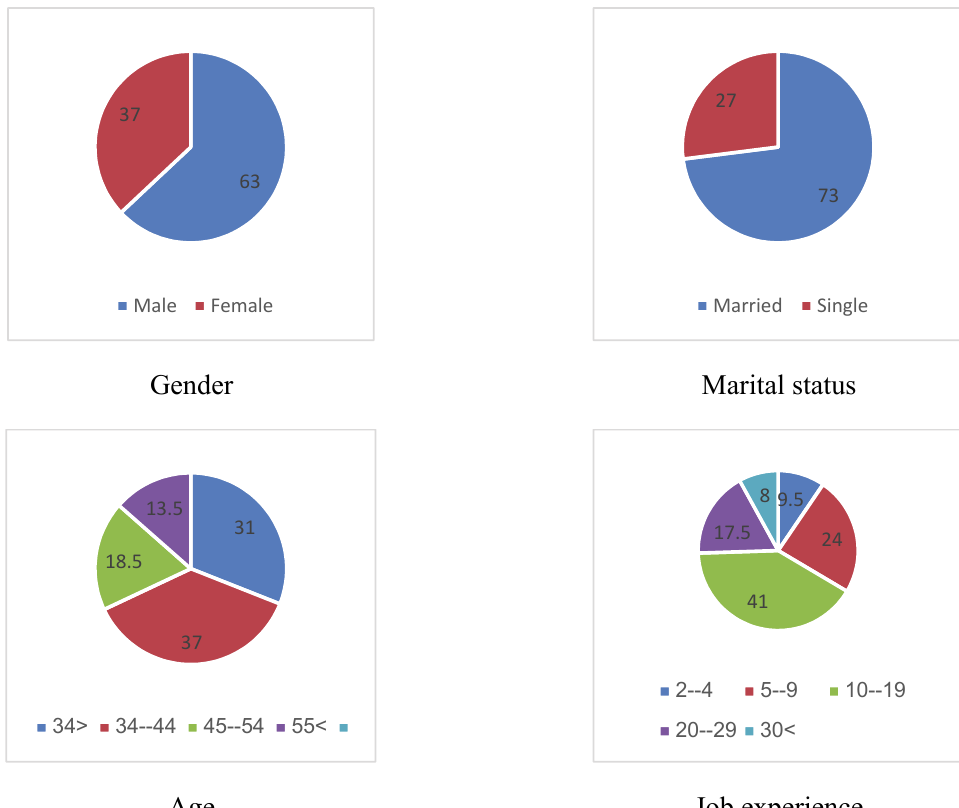
Fig. 2. Personal characteristics of the